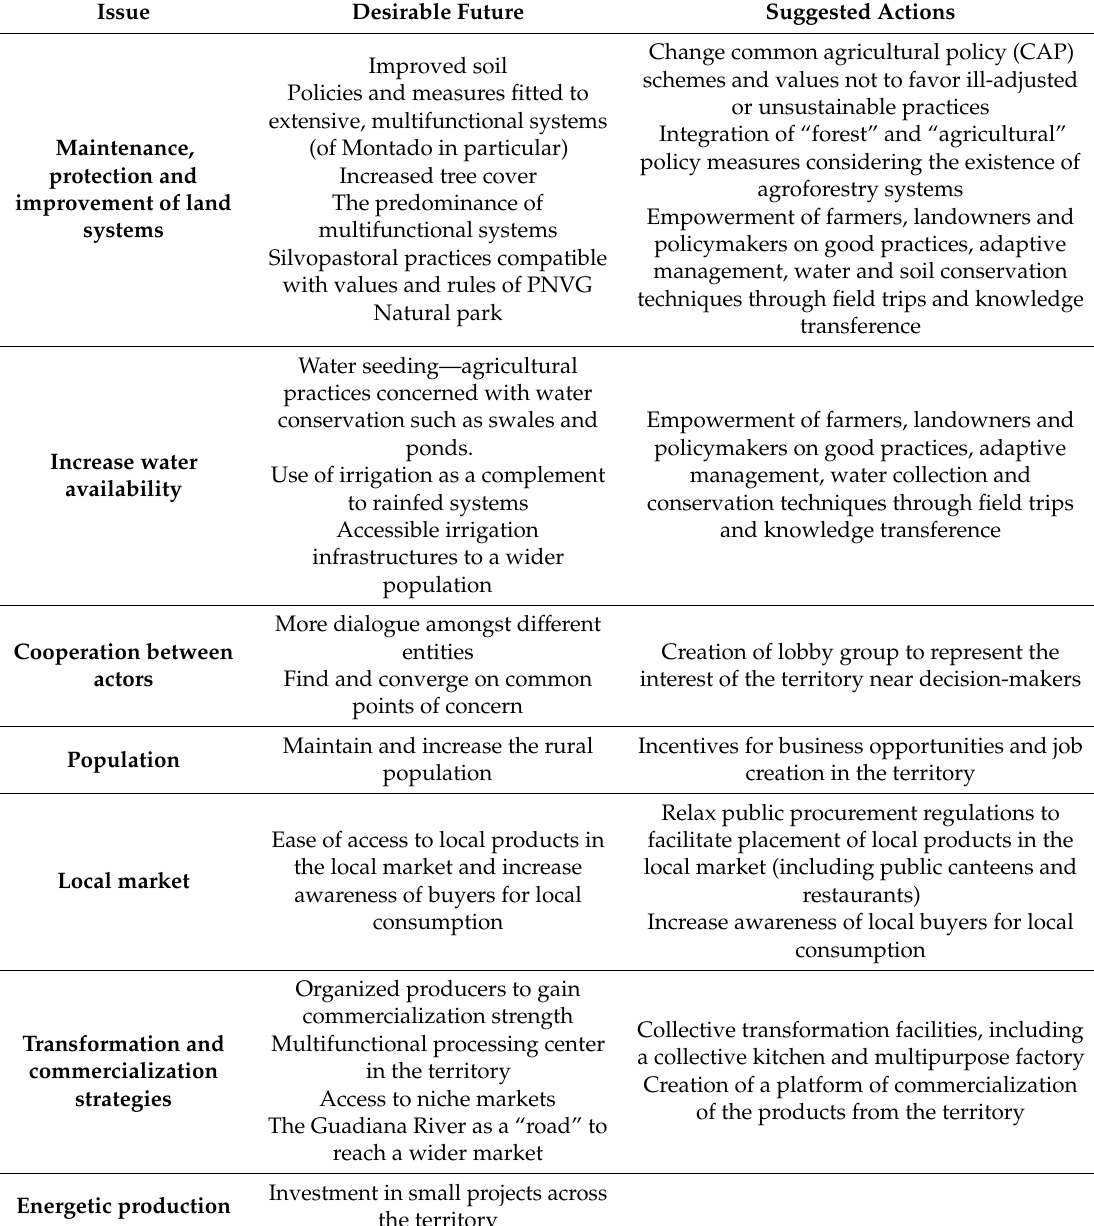
Table 3. Desired future and possible